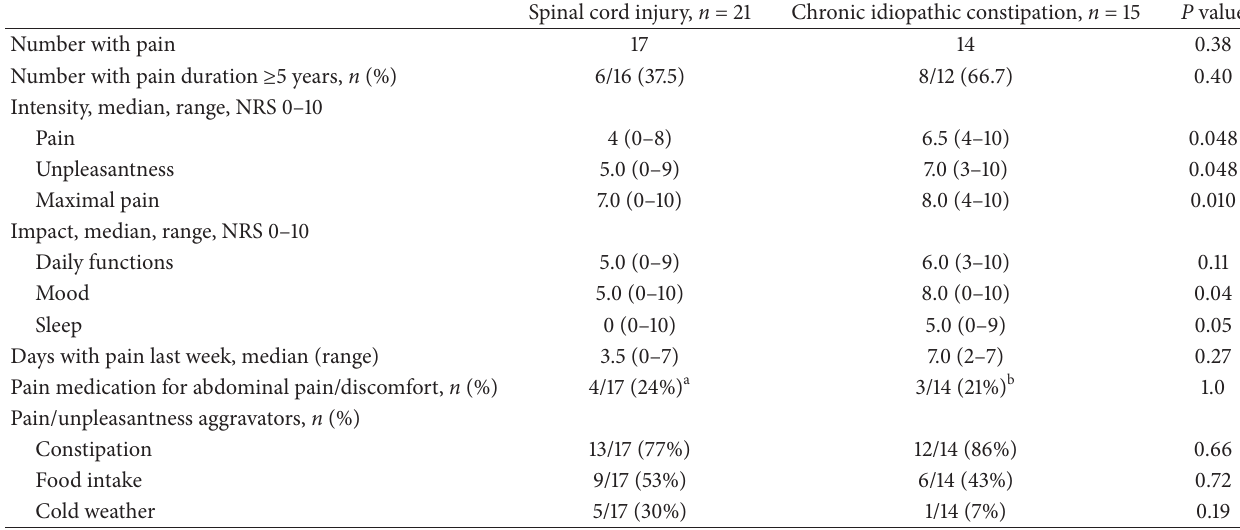
Table 3: Abdominal pain characteristics. Data obtained from our 18-item